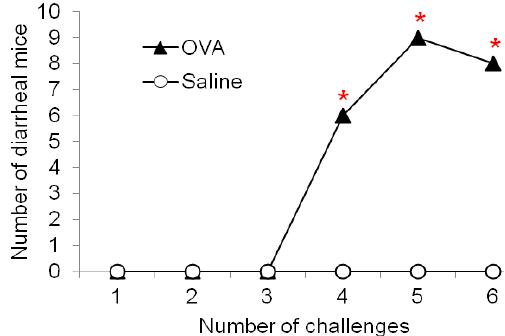
Figure 1. Changes in time course of the number of diarrheal mice. Diarrhea occurrence of OVA-sensitized (▲) and saline-sensitized (○) mice was assessed after 1st to 6th OVA challenges. (n = 12 mice/group; * p<0.05).